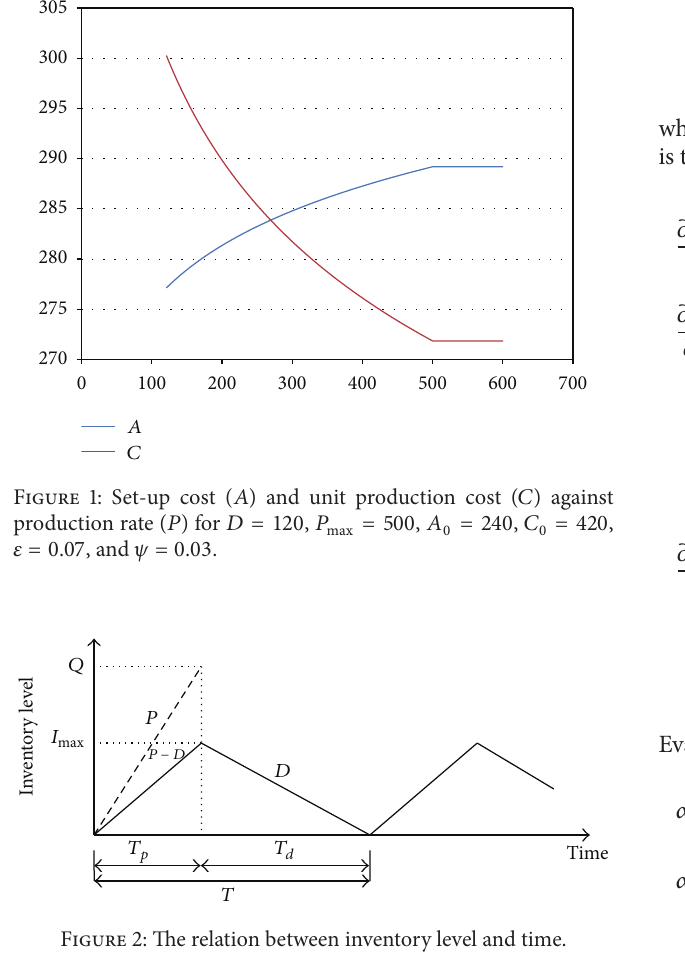
on unit production cost of the